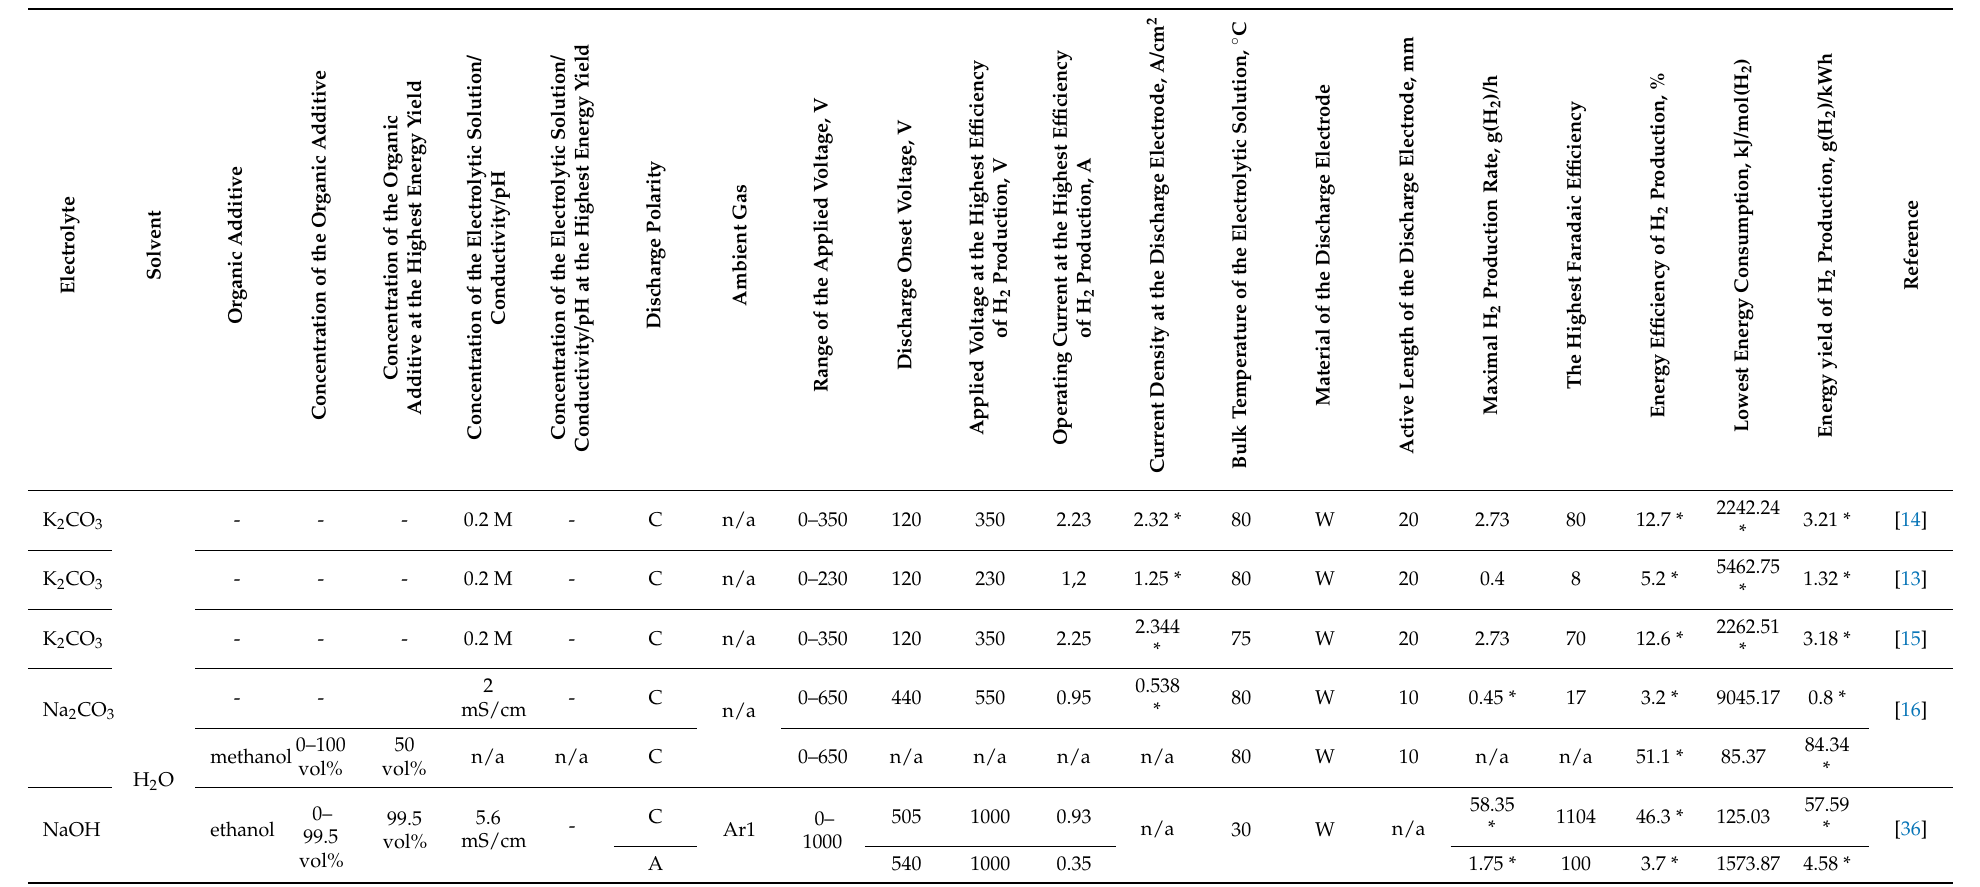
Table 2. Review of research on the production of hydrogen by PDSE and its